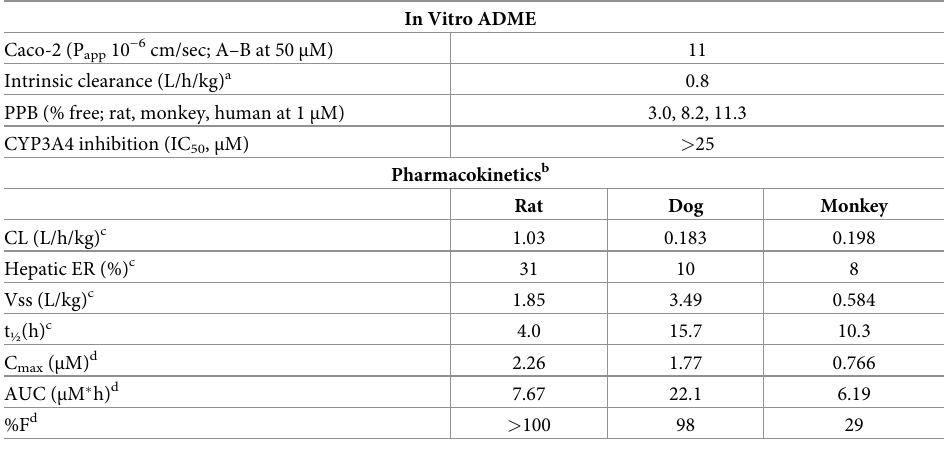
Table 2. In vitro ADME and pharmacokinetics of